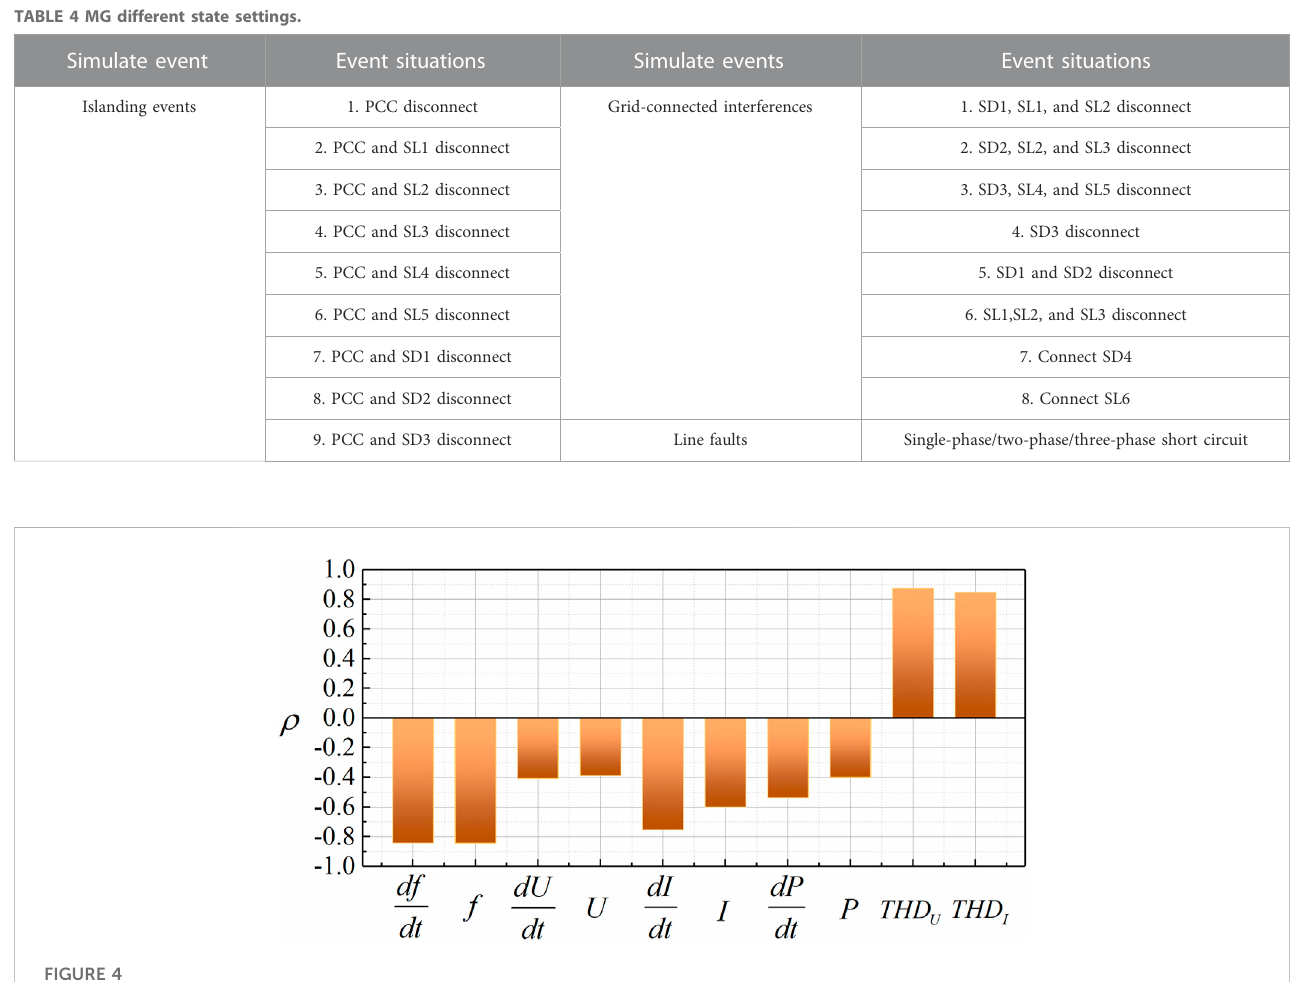
FIGURE 4 Spearman correlation coef fi cient between each electrical quantity and MGs state.